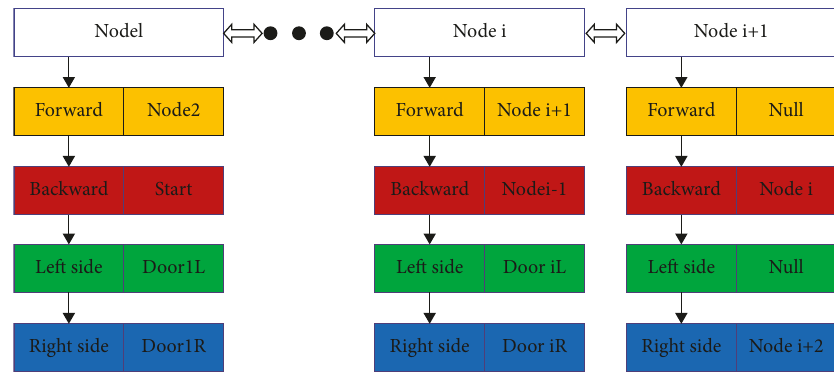
Figure 7: Topological semantic map